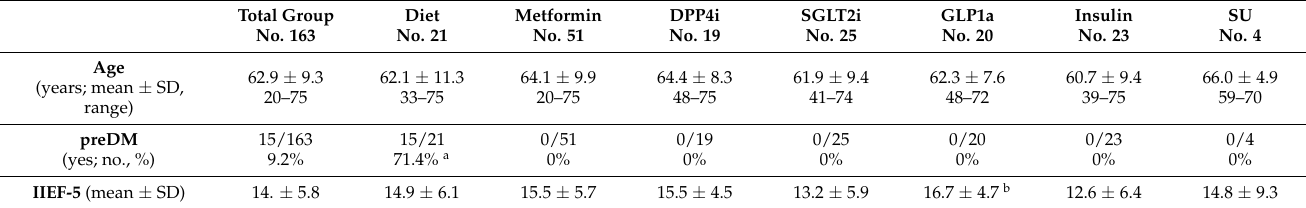
Table 1. Basal characteristics of patients, in the total group and in subgroup according to antidiabetic treatment. DPP4i = dipeptidyl-peptidase-4 inhibitors; GLP-1 = glucagon-like peptide-1receptor agonists; SGLT2i= sodium-glucose cotransporter-2 inhibitors; SU = sulfonylureas; IIEF = International Index of Erectile Function; DM = diabetes mellitus; BMI = body mass index; CV = cardiovascular. a p < 0.05 vs. total group. b p < 0.05 vs. insulin. c p < 0.05 vs. total group. d p < 0.05 vs. SGLT2i and GLP-1